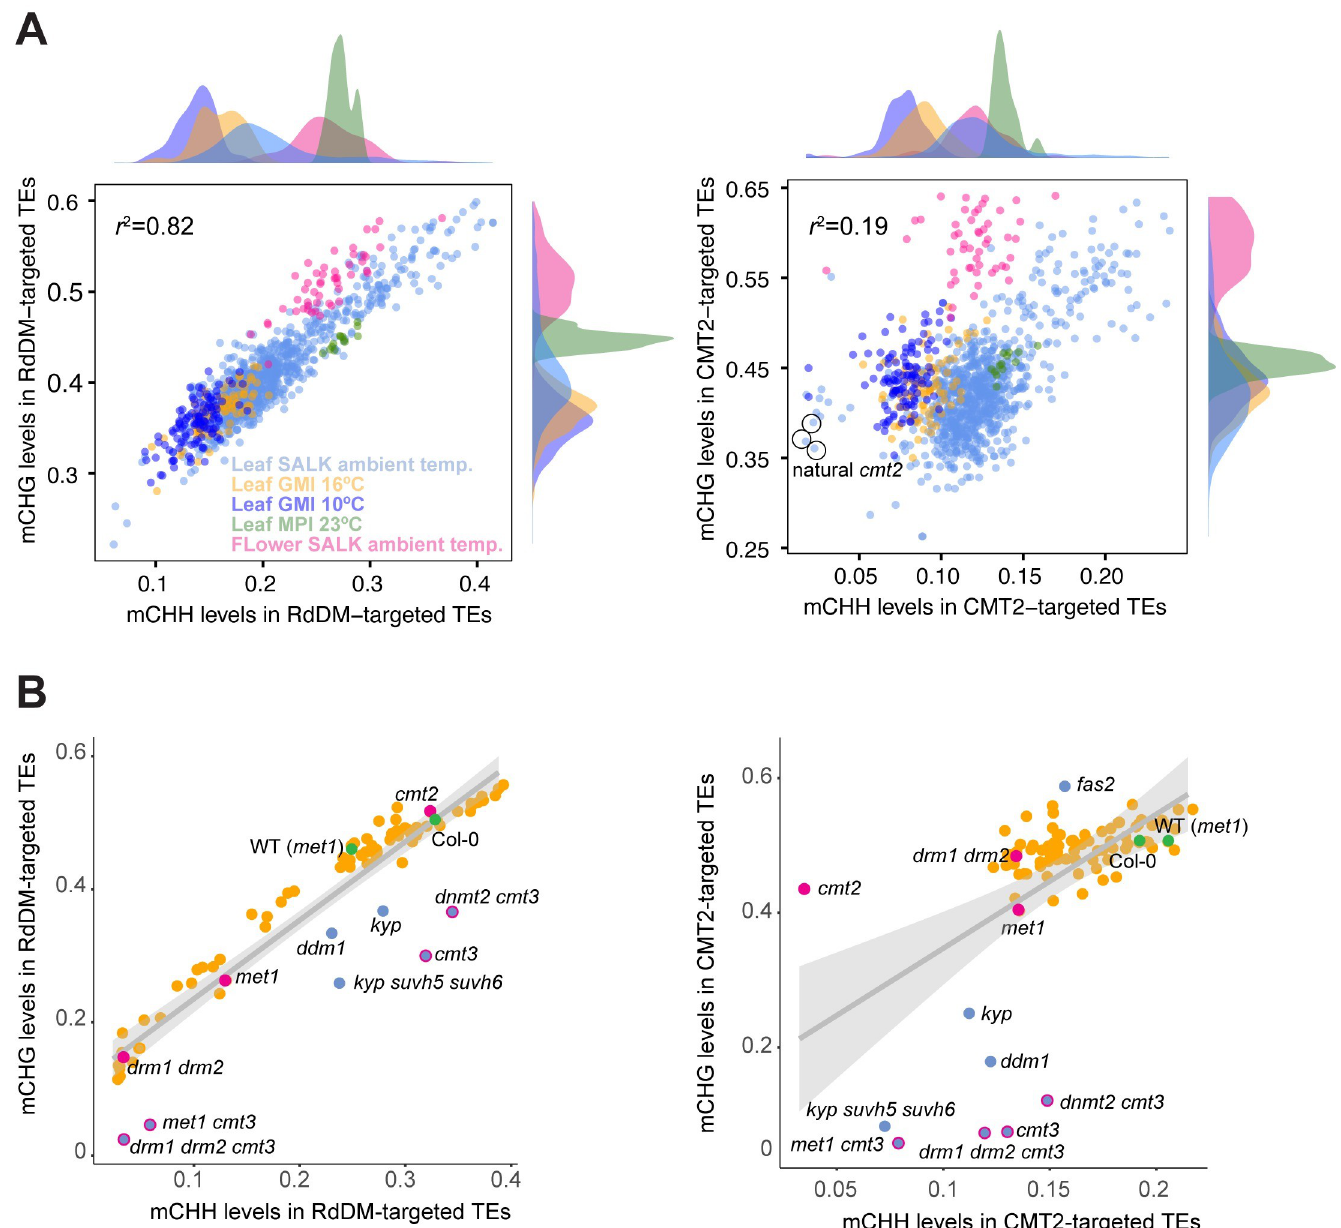
Fig 1. Covariance between mCHH and mCHG levels across individuals. (A) Correlation of genome-wide average mCHH and mCHG levels in RdDM- and CMT2-targeted transposons across 1028 natural inbred lines measured in different conditions (including 79 lines measured in more than one condition; see [20]) Colors correspond to environments/tissues. Plots on axes show marginal densities. Circled lines carry known natural null alleles of CMT2 . (B) The same correlation as in A, but for 84 epigenetics-related loss-of-function mutants [27]. Gray areas indicate 99% confidence intervals around the linear regression lines. Green points denote “wildtypes” (see [27]); magenta, major DNA methyltransferases. Blue points denote lines with a highly significant effect on